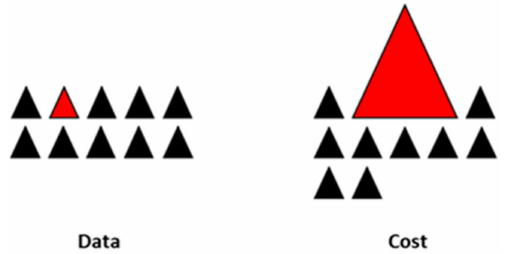
Figure 5. Conception of cost